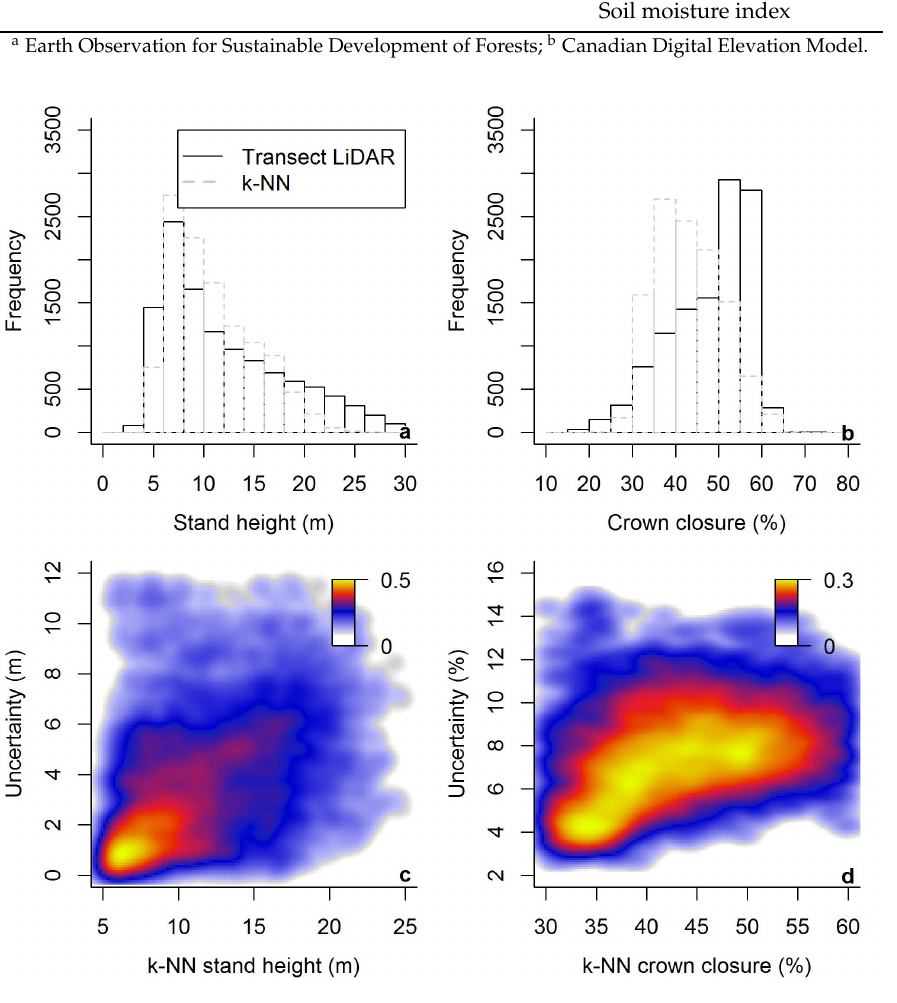
Figure 6. Comparisons of transect LiDAR and regionally mapped k-NN distributions of ( a ) stand height, and ( b ) crown closure, and the relationship between k-NN attributes and their associated uncertainties for ( c ) stand height, and ( d ) crown closure (yellow shades indicate higher point density, as noted by inset legends). Comparisons are based on 1% of intersecting transect LiDAR data, resulting in 11,401 points (after removal of fire affected